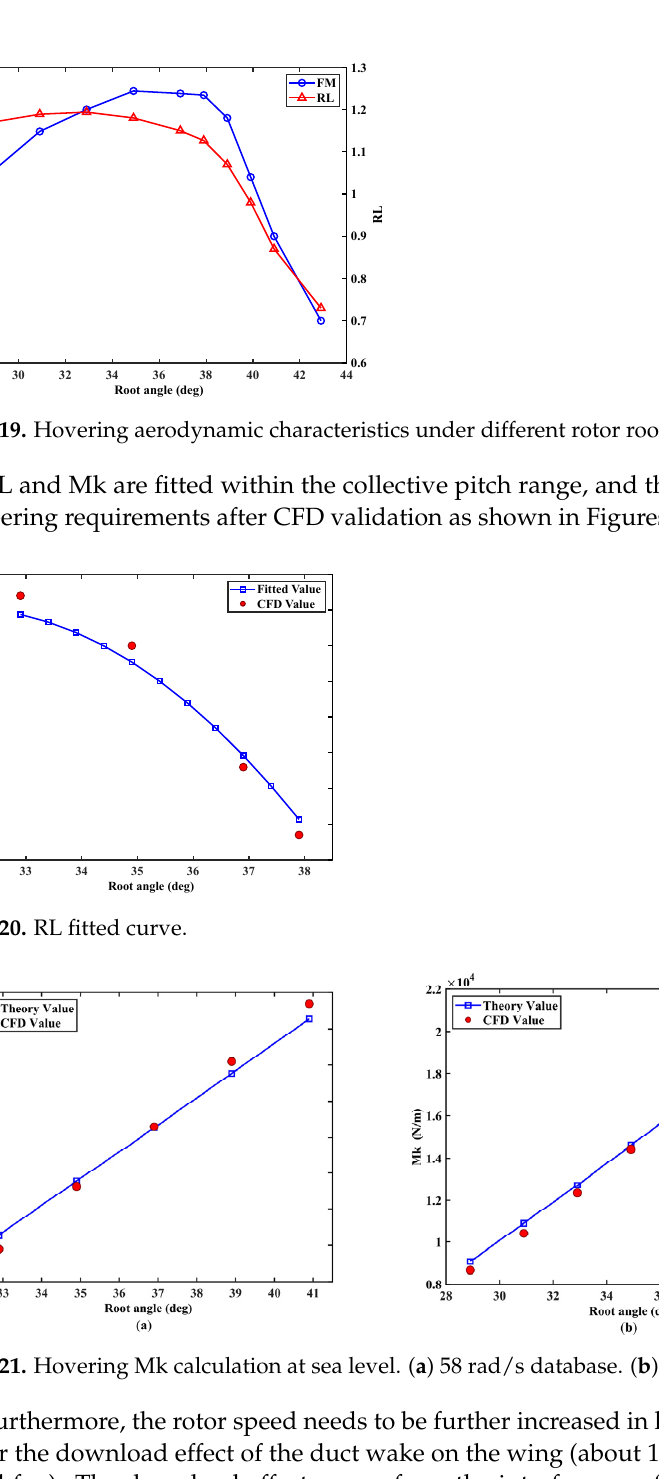
Figure 22. Download pressure nephogram of wing surface. Taking into account the design goal requirements, the maximum download effect, the tonnage matching engine series [23], and the altitude characteristics of typical